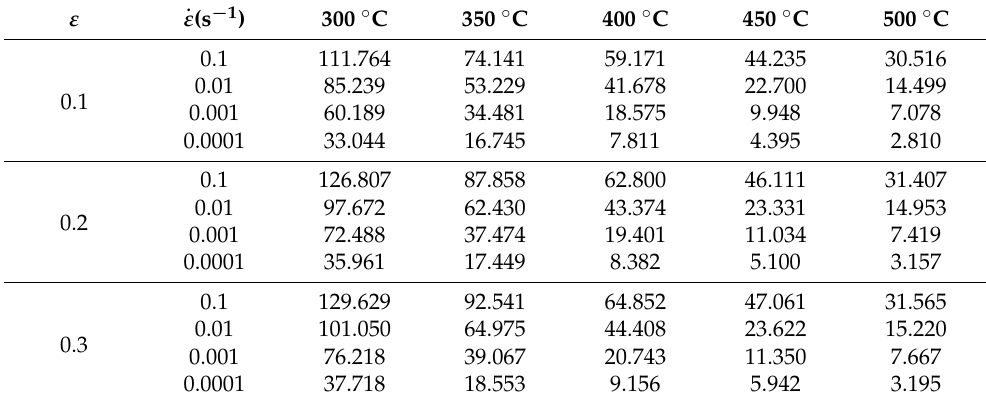
Table 3. Flow stresses for MnE21 magnesium alloy based on various deformation conditions